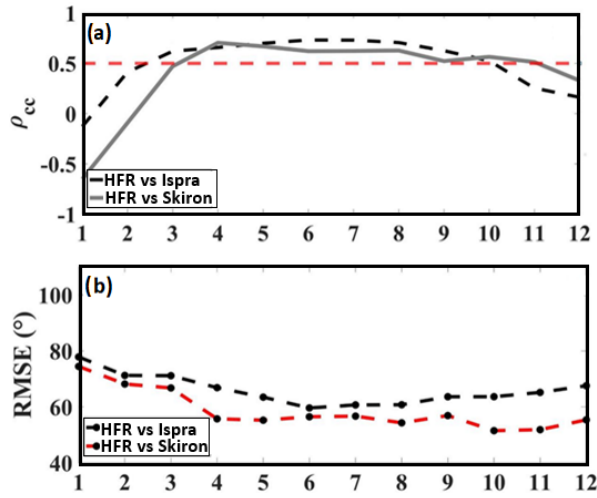
Figure 6. Variation of the (a) circular correlation coefficient ( ρ cc ) and (a) RMSE on different range cells (km from site), derived from the comparison of HFR-GoN wind direction against data provided by a weather station (ISPRA) and a numerical model (SKIRON) for the event that occurred during 6–8 February 2009 in the GoN. The red dashed line in (b) shows the circular correlation coefficient threshold (0.5), since values of ρ cc > 0 . 5 indicate a reasonable cor- relation between the measurements (Saviano et al.,